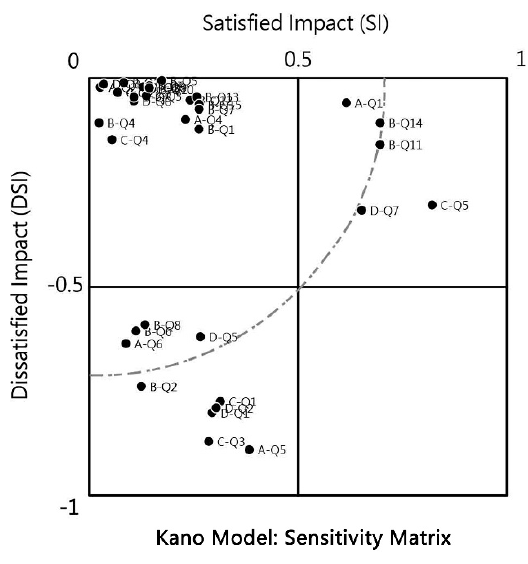
Figure 11. Sensitivity matrix of Kano model questionnaire for functional